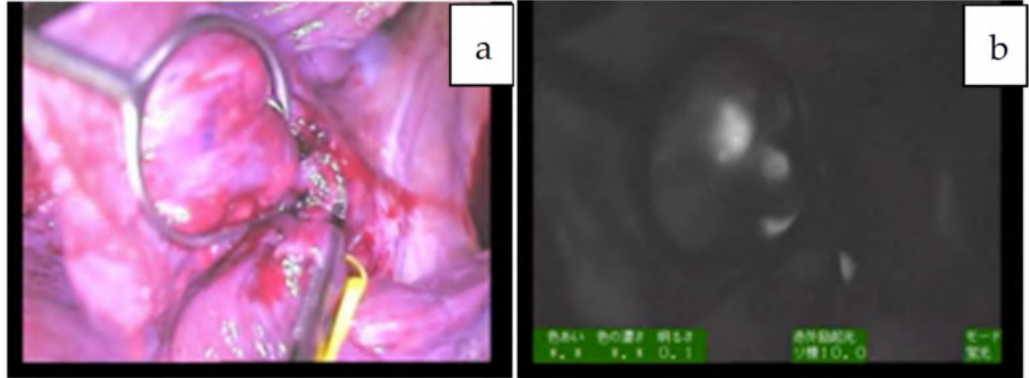
Figure 5. a , b : Several pulmonary metastases are visualized in NIR mode (patient 19; transitional liver cell